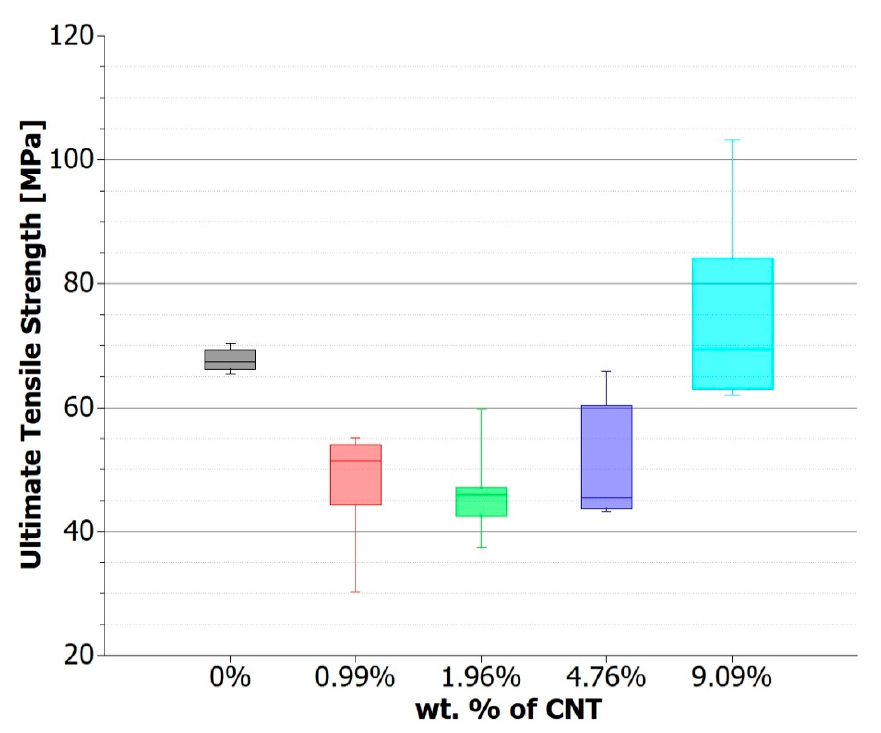
Figure 6. Comparison of ultimate tensile strength values for composite samples with different CNTs loading (from 0.99 to 9.09 wt.%), and with ABS reference samples (0 wt.% of CNTs).